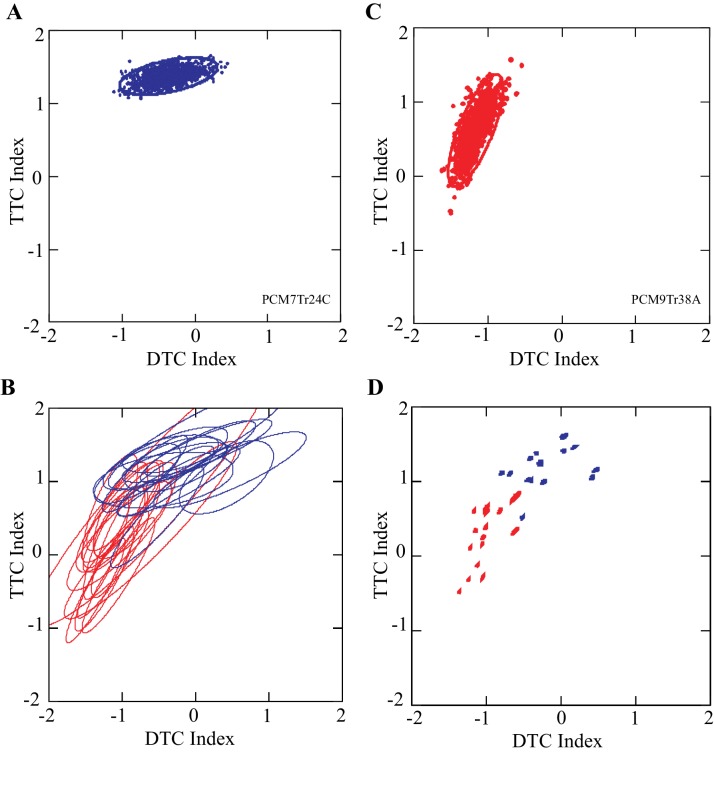
Bootstrapped data for index of TTC- and DTC-related cells.For each cell, we used a replacement protocol to create 1000 datasets for each DTC- and TTC-related cell included in Figure 5D. We treated data for the matched and visual dissociation tasks separately but combined data for the left and right lead conditions. The number of points in each condition equaled the original dataset. A and B show the bootstrapped indexes for the two cells illustrated in Figure 4 and indicated by the asterisk in Figure 5D. The ellipse indicates the 95% confidence level. The ellipses for all the cells included in Figure 5D are illustrated in (C); D illustrates the centroids of these ellipses. Although there is some overlap of the two ellipses, the bootstrapped data separate into two groups in the same way as the original datasets.